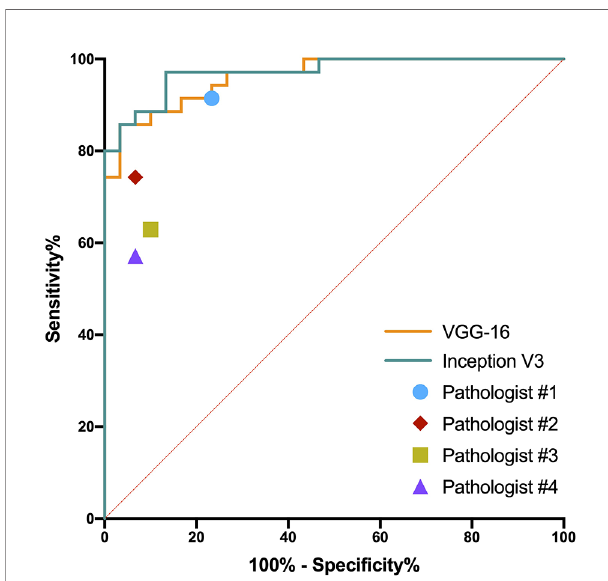
FIGURE 5 | Receiver operating characteristic curves in the slide-level binary classi fi cation of VGG-16 and Inception V3, along with results of pathologists ’